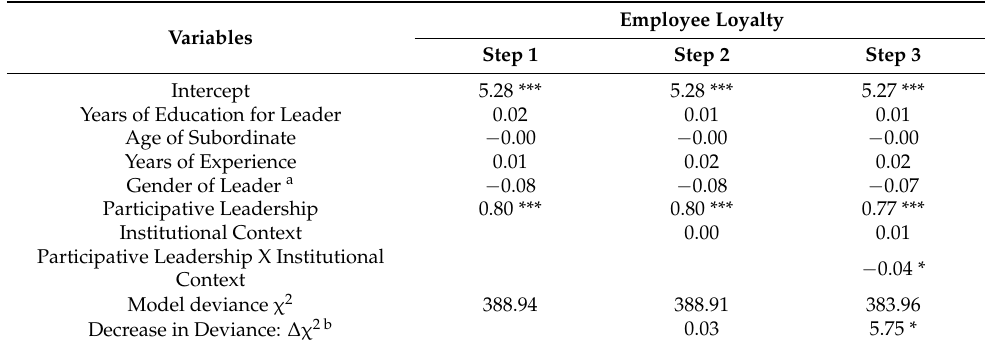
Table 2. Results of hierarchical linear modeling analyses.